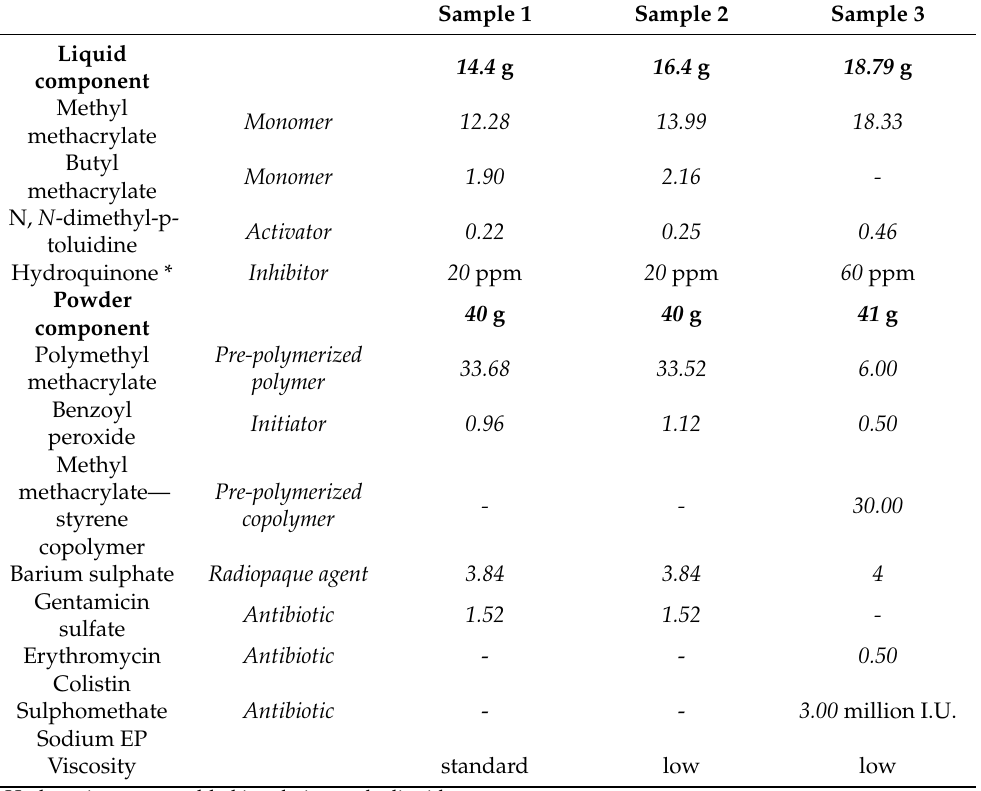
Table 2. Chemical composition of the experimental samples of acrylic bone